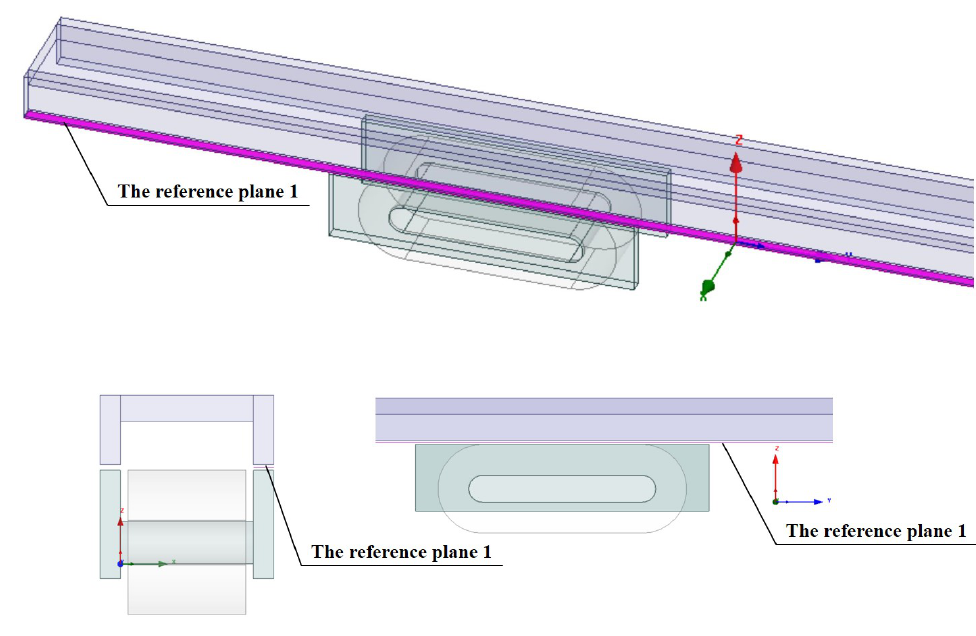
Figure 16. Position of reference plane 1.